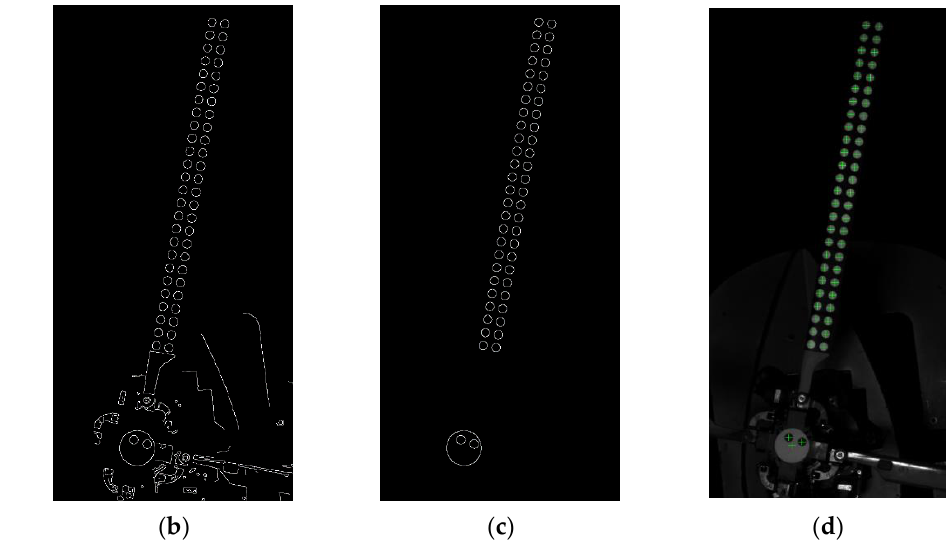
Figure 8. Target detection and location. ( a ) An example image. ( b ) Image edges extraction. ( c ) Target detection. ( d ) Target location. detection. ( d ) Target